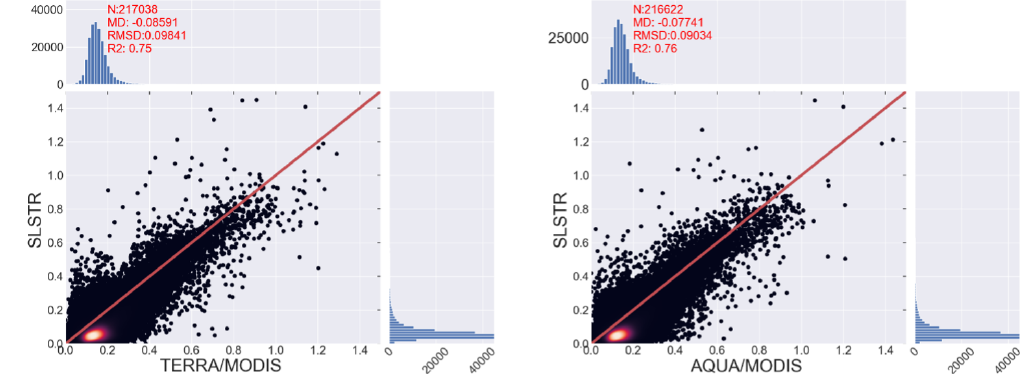
Figure B1. S3A/B–SLSTR vs. MODIS AOD scatter plots of temporal mean AOD over ocean for the DJF period.